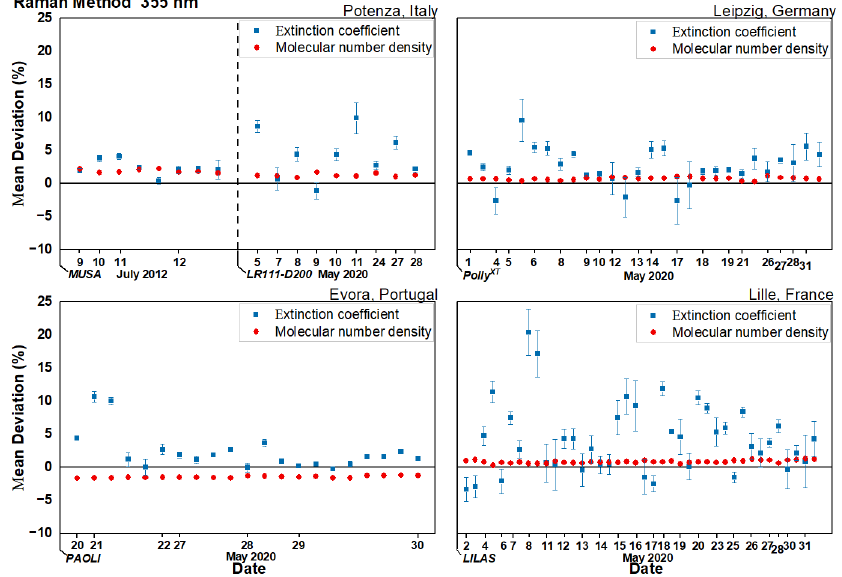
Figure 1. Mean relative deviations of extinction at 355 nm for the four stations, where the deviation refers to the difference between the values calculated with ERA5 to the values calculated with the forecast (IFS_ECMWF or GDAS). Blue and red dots represent the mean relative deviation of aerosol extinction and molecular number density, respectively. The Date axis is not linear in time. It reports the dates (just one after the other) corresponding to the performed optical inversions. For example, for MUSA system (upper plot on the left) there is only one optical inversion available for 10 July 2012 and three for 11 July 2012.